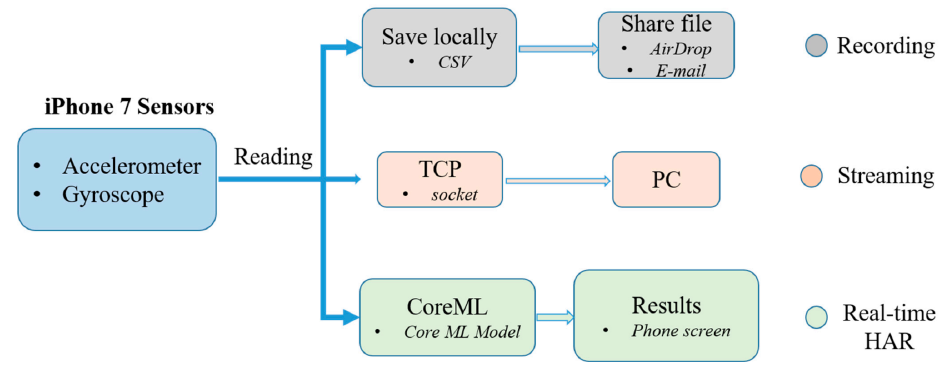
Figure 13. Application program